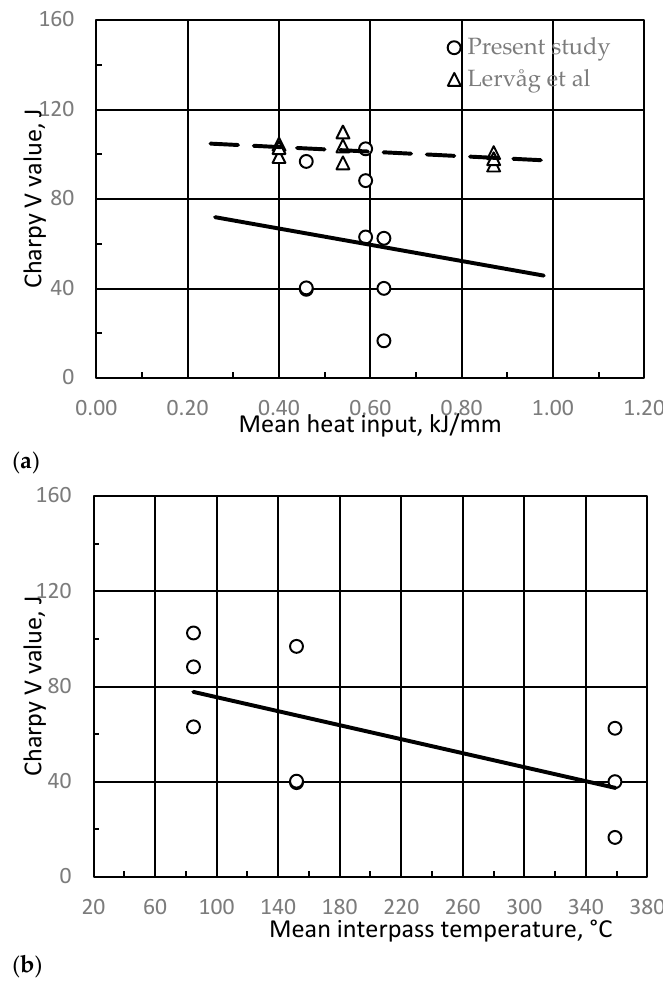
Figure 4. Charpy V results; tested at − 46 °C. Data for − 20 °C taken from Lervåg et al. [19]. ( a ) Effect of mean heat input, and ( b ) effect of mean interpass temperature. The results from the present study are compared with previous data for superduplex steels, indicating that there is a certain temperature effect; the previous results are from testing at − 20 °C while the current walls are tested at − 46 °C. The previously published data by Lervåg et al. [19] illustrate that the toughness of the walls is nearly independent of the gross arc energy due to limited microstructure variations; the Charpy values are all close to 100 J. However, it is reasonable to assume that the major reason for the toughness fall is due to σ formation, especially for the 0.63 kJ/mm heat input combined with high interpass temperature.